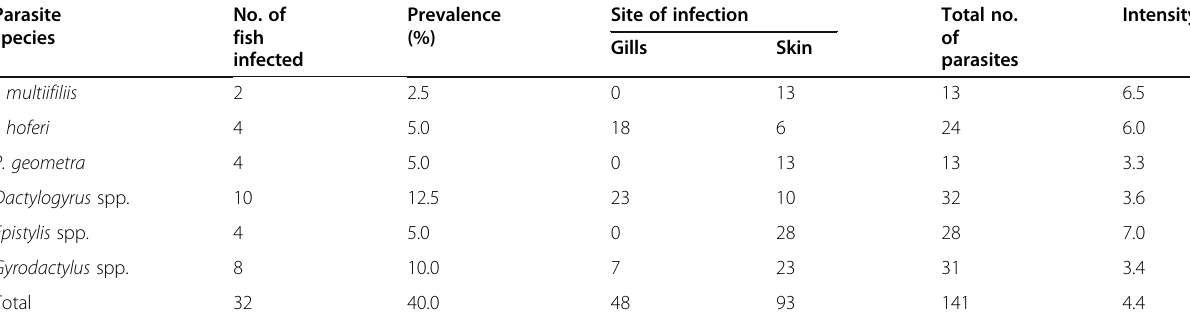
Table 6 Distribution of ectoparasites in relation to the site of infection on infected C. gariepinus Parasite species